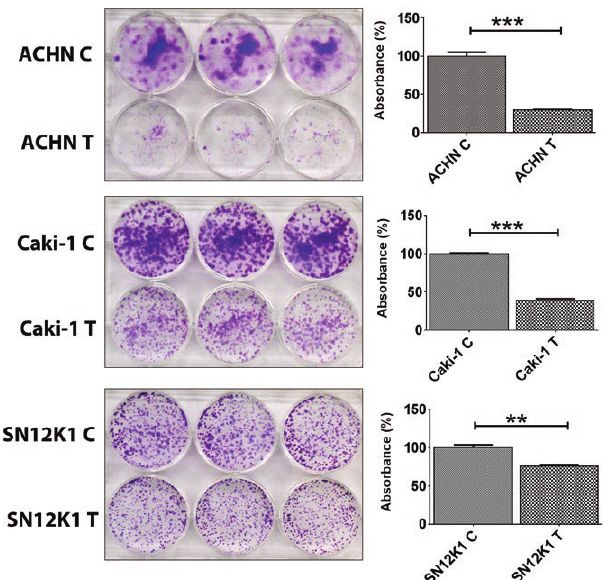
Figure 3. Maslinic acid significantly reduced colony formation. Adhesion and colony formation are essential steps in distant metasta- sis. Maslinic acid significantly decreased colony formation of all three cell lines. Left, representative images showing colony formation. Right, quantification of the dye. ** P < 0.01; *** P < 0.001. C: untreated control; T: treated with maslinic acid.